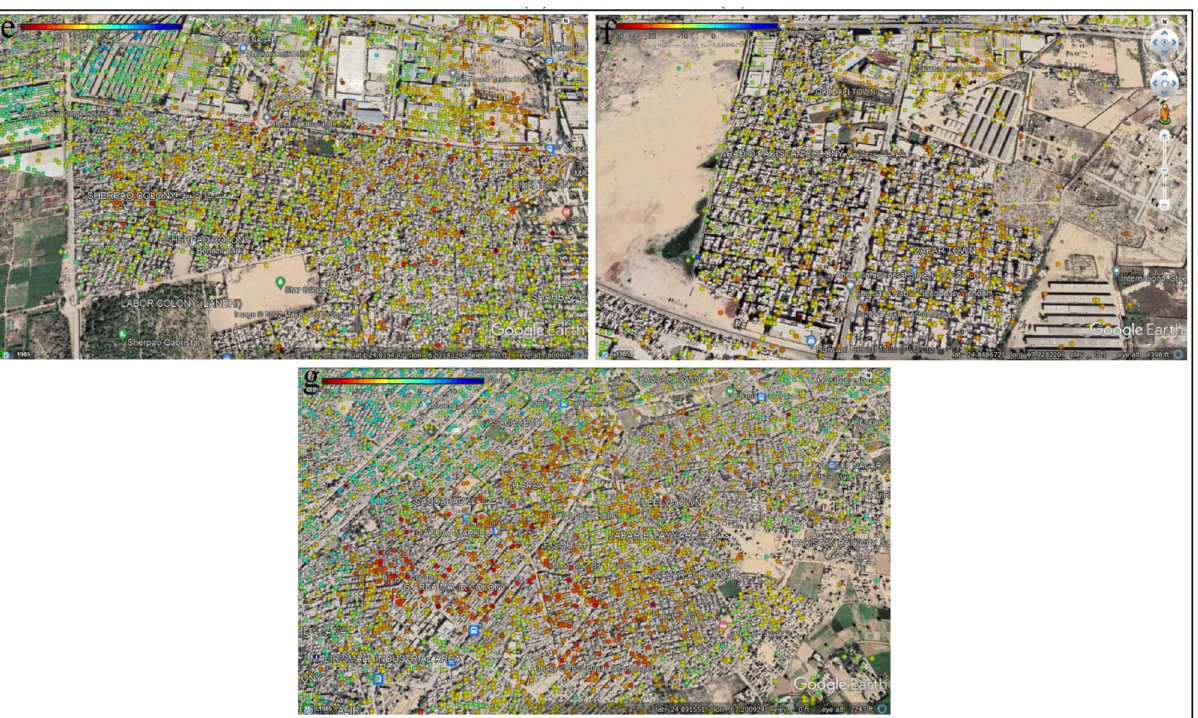
Figure 12. Vertical displacement in Karachi, ( e ) Sherpao Colony, ( f ) Radio Pakistan Colony, ( g ) Milar Areas.